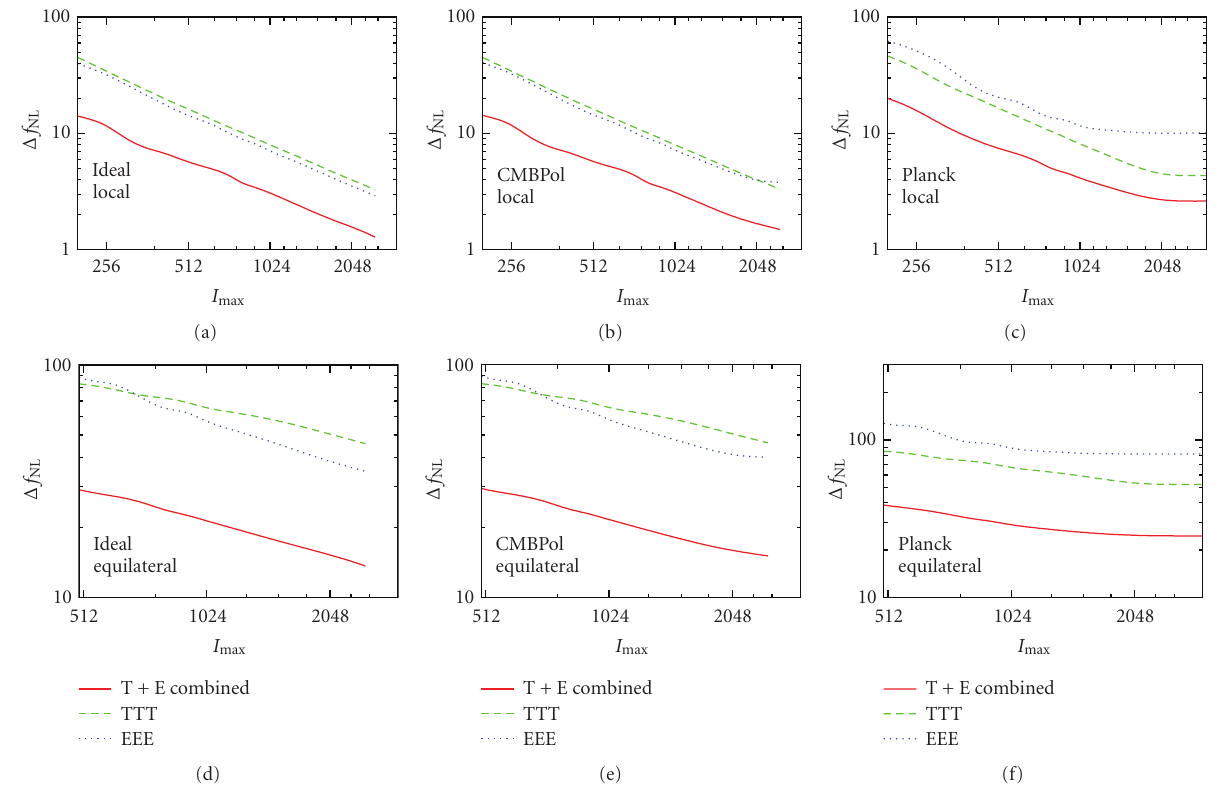
Figure 7: Fisher predictions for minimum detectable f NL (at 1 σ ) as a function of maximum multipole (cid:8) max . Upper panels are for the local model while ((d),(e), and (f)) are for the equilateral model. ((a) and (d)) show an ideal experiment, ((b) and(e)) are for CMBPol like experiment with noise sensitivity Δ p = 1 . 4 μ K-arcmin and beam FWHM σ = 4 (cid:3) and ((c) and (f)) are for Planck- like satellite with and noise sensitivity Δ p = 40 μ K-arcmin and beam FWHM σ = 5 (cid:3) . In all the panels, the solid lines represent temperature and polarization combined analysis; dashed lines represent temperature only analysis; dot-dashed lines represent polarization only